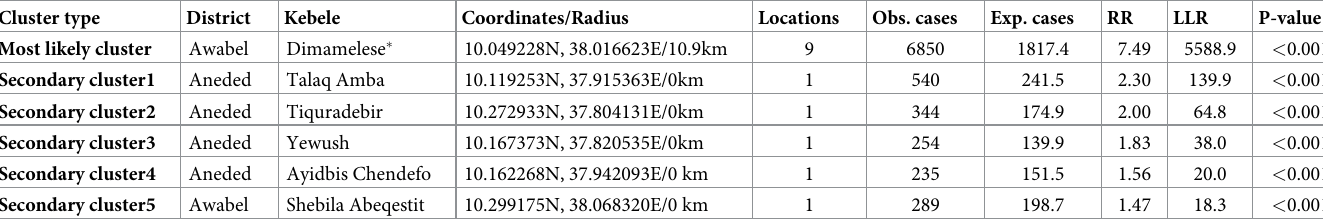
Table 5. Most likely and secondary clusters of malaria cases in Aneded and Awabel districts between epi week 37/2013 and 38/2018.